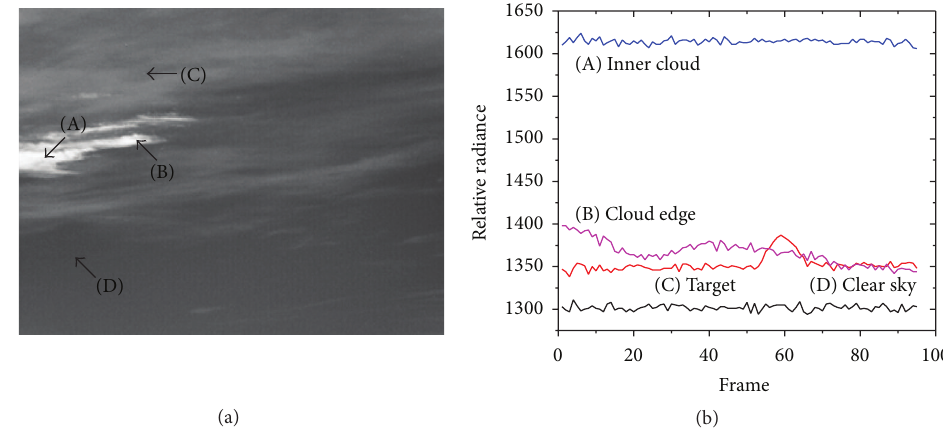
Figure 7: Temporal profiles of a target, clear sky, inner cloud, and cloud edge pixel. (a) One frame of an IR image sequence. (b) Temporal